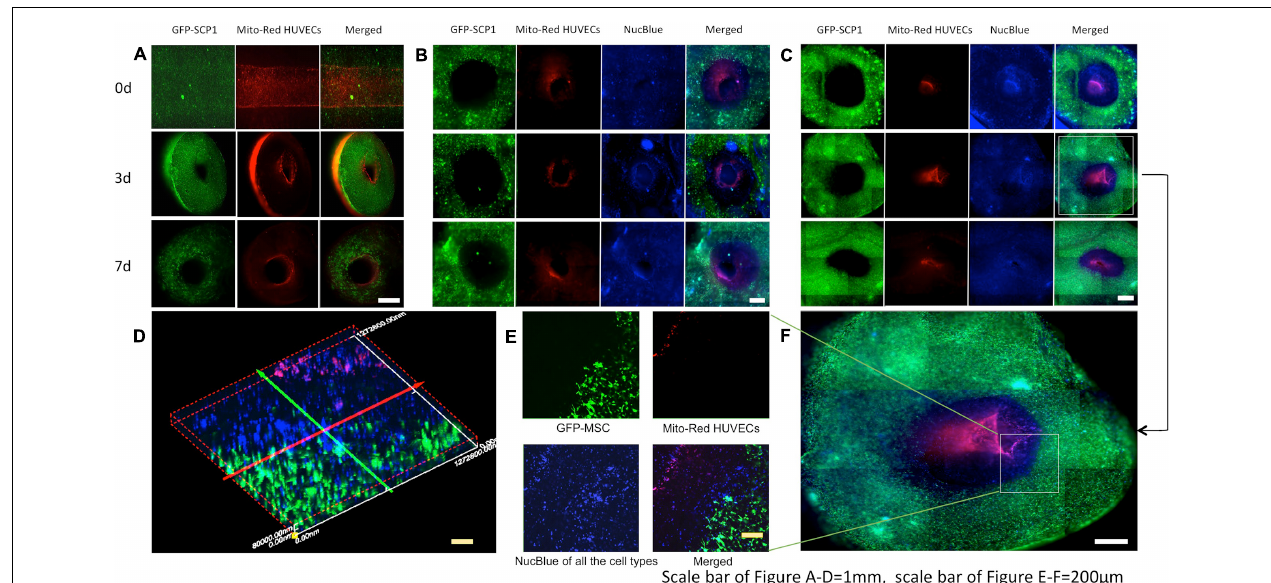
FIGURE 4 | Fluorescence images of multilayer structures, mimicking vessel layers in the hydrogels at different time-points of perfusion. (A) Images of two-layer vessel structures after 0,3,7 days perfusion. (B) Images of three-layer vessel structures in fibrin hydrogels after 0,3,7 days perfusion. (C) Images of three-layer vessel structures in collagen hydrogels after 0,3,7 days perfusion. (D) Vessel structure formation and cell growth in collagen hydrogels after 3-day perfusion. (E) Confocal microscopic image of three-layer structure in the hydrogels. (F) 3D reconstruction of three-layer structure in panel (E)